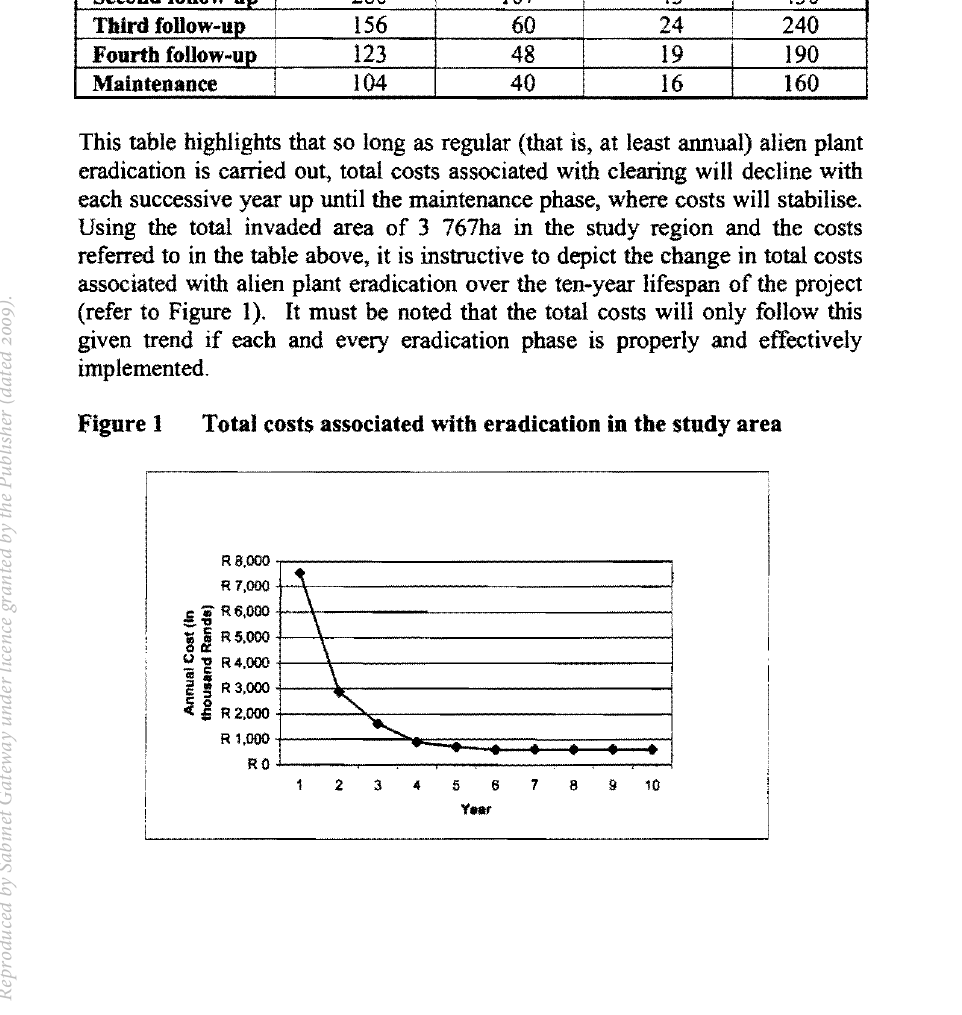
Total costs associated with eradicating alien invasive vegetation for different phases Stages of eradi- Labour cost